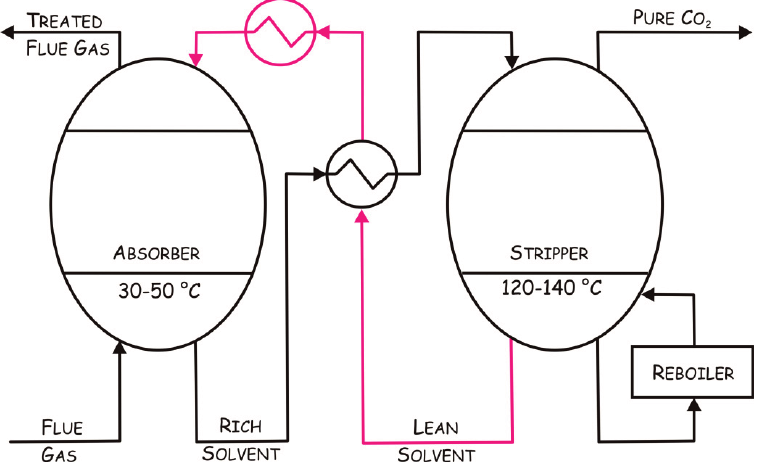
Figure 1. Schematic representation of a chemical absorption process. Red lines indicate the absorber regeneration